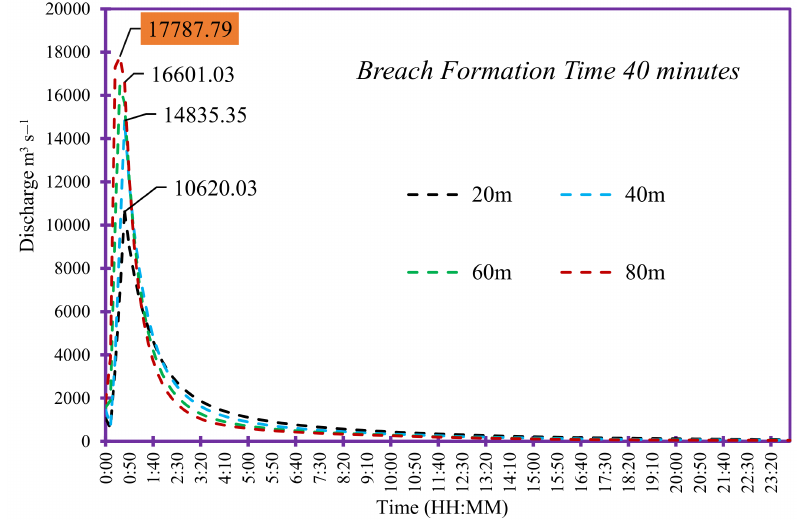
Figure 12. Moraine breach hydrographs showing peak discharge with varying beach widths (20, 40, 60, 80).